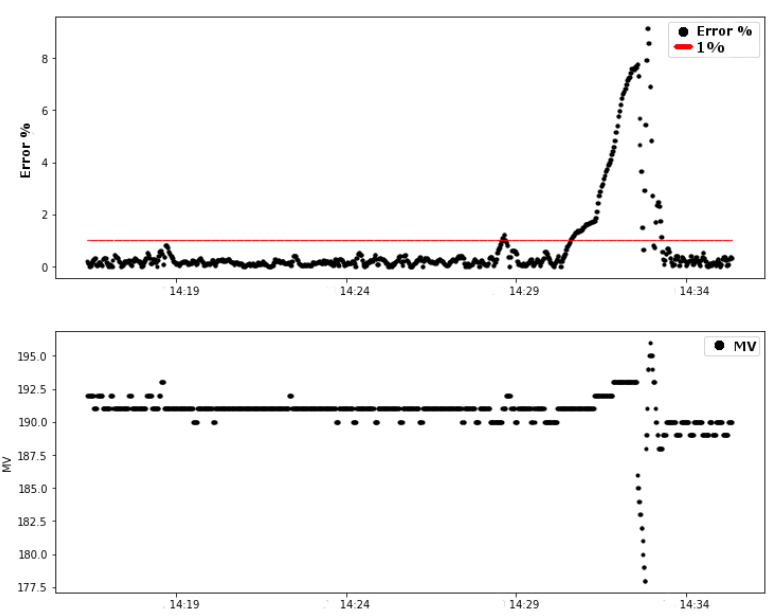
Figure 8. Test 01: Variables of the control loop (error and